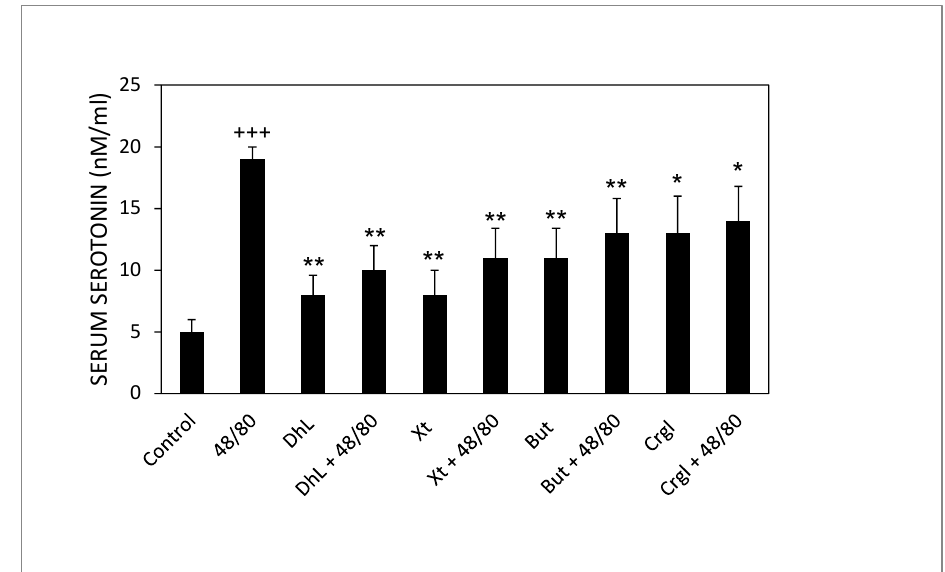
Figure 7. Effect of DhL, Xt, But, and Crgl on rat serum serotonin levels induced by compound 48/80. Values of serotonin concentrations are expressed as mean ± SEM +++ p < 0.001 when compared with the control group, ** p < 0.01 when compared with the compound 48/80 group, and * p < 0.05 when compared with the compound 48/80 group.